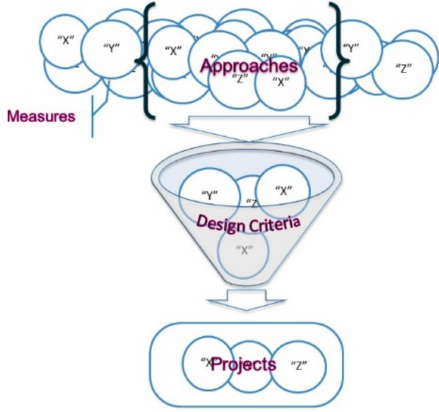
Figure 1. Schematics of flood measures, approaches, design criteria, and